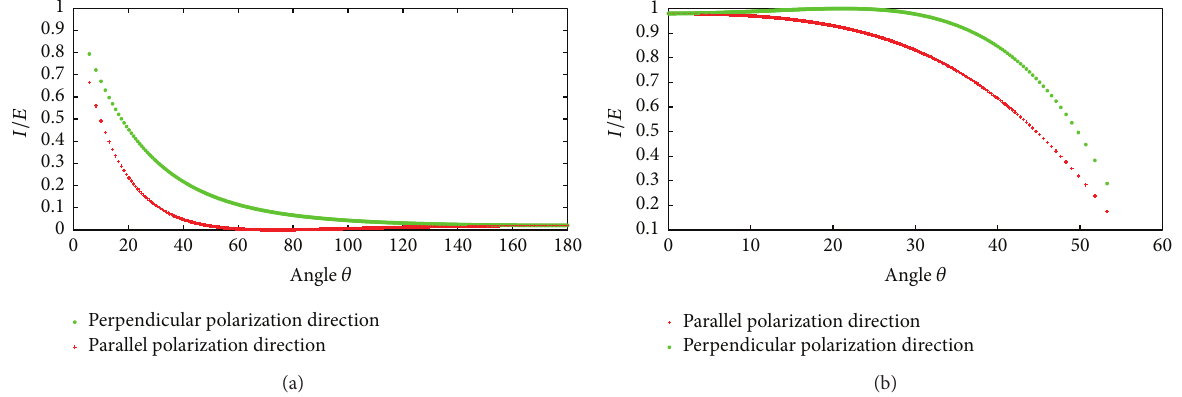
Figure 4: Geometric scattering of raindrops on the two polarization directions ((a) simple reflection; (b) twofold